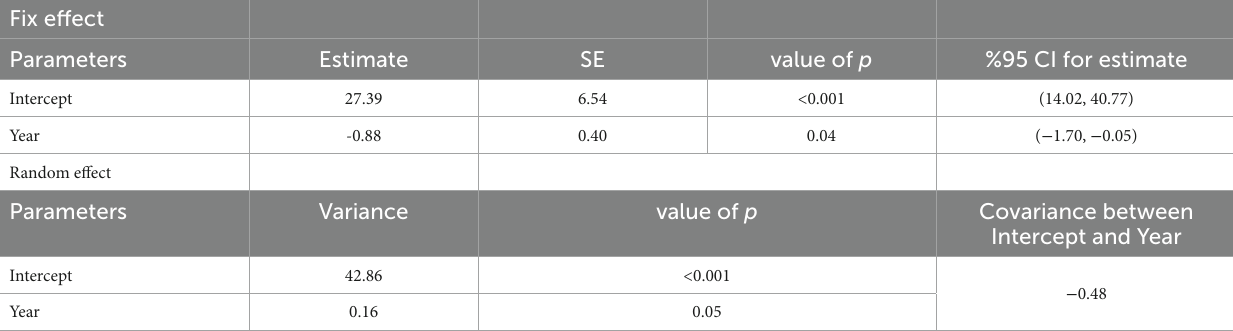
TABLE 2 The incidence trend of cutaneous leishmaniasis in various provinces of Iran by the fix and random effect models, 2013–2020.